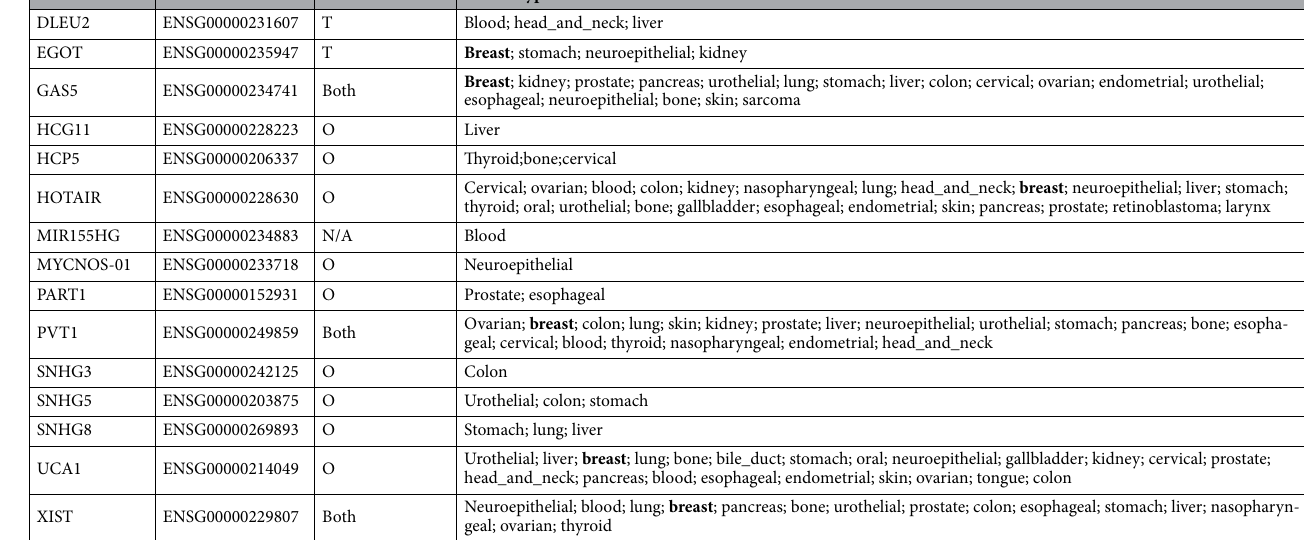
Table 2. Functional information of lncRNAs as reported the Cancer lncRNA Census 2.0. T tumor suppressors, O oncogenes.